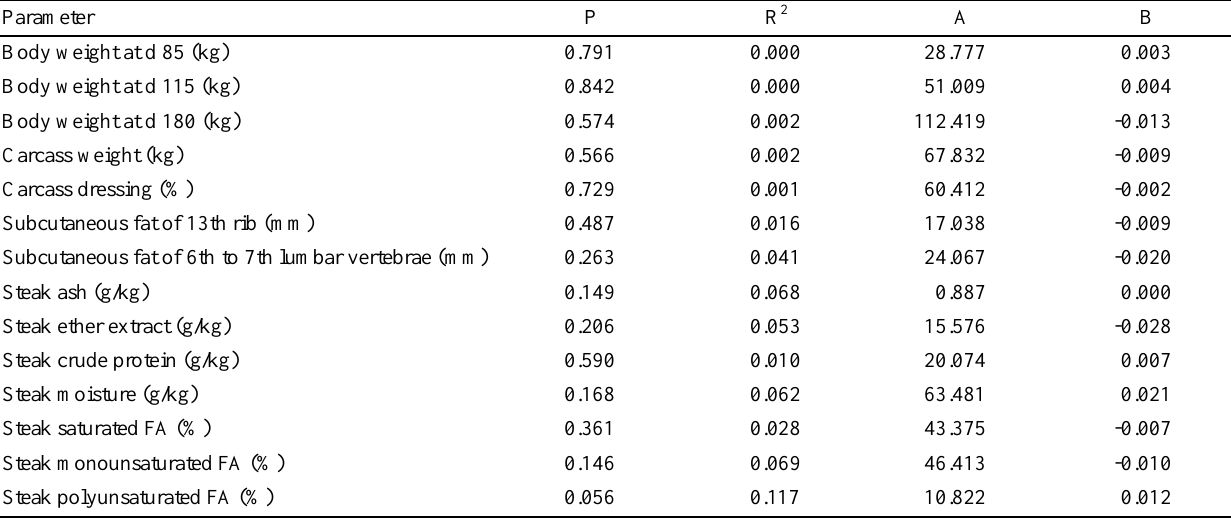
Table 6. Regression analysis of the effect of dietary carob pods on pig performance and meat quality parameters